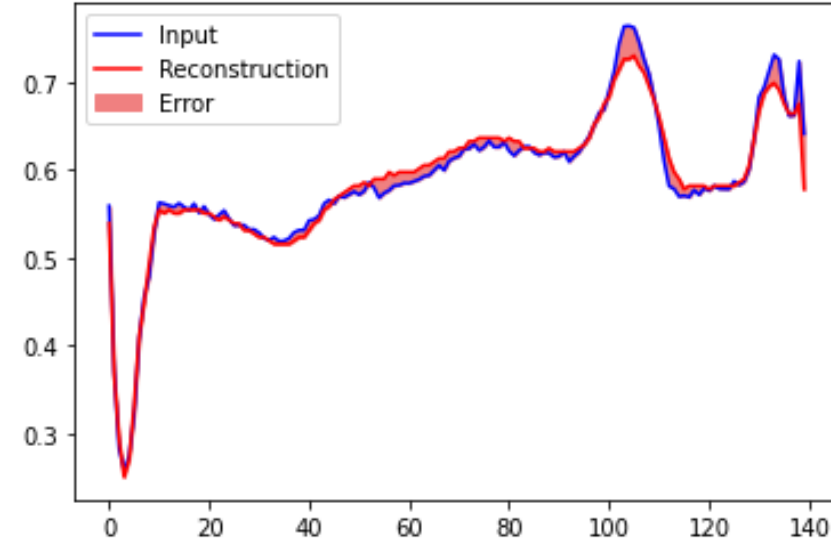
Figure 7. Original input vs. reconstructed decoder